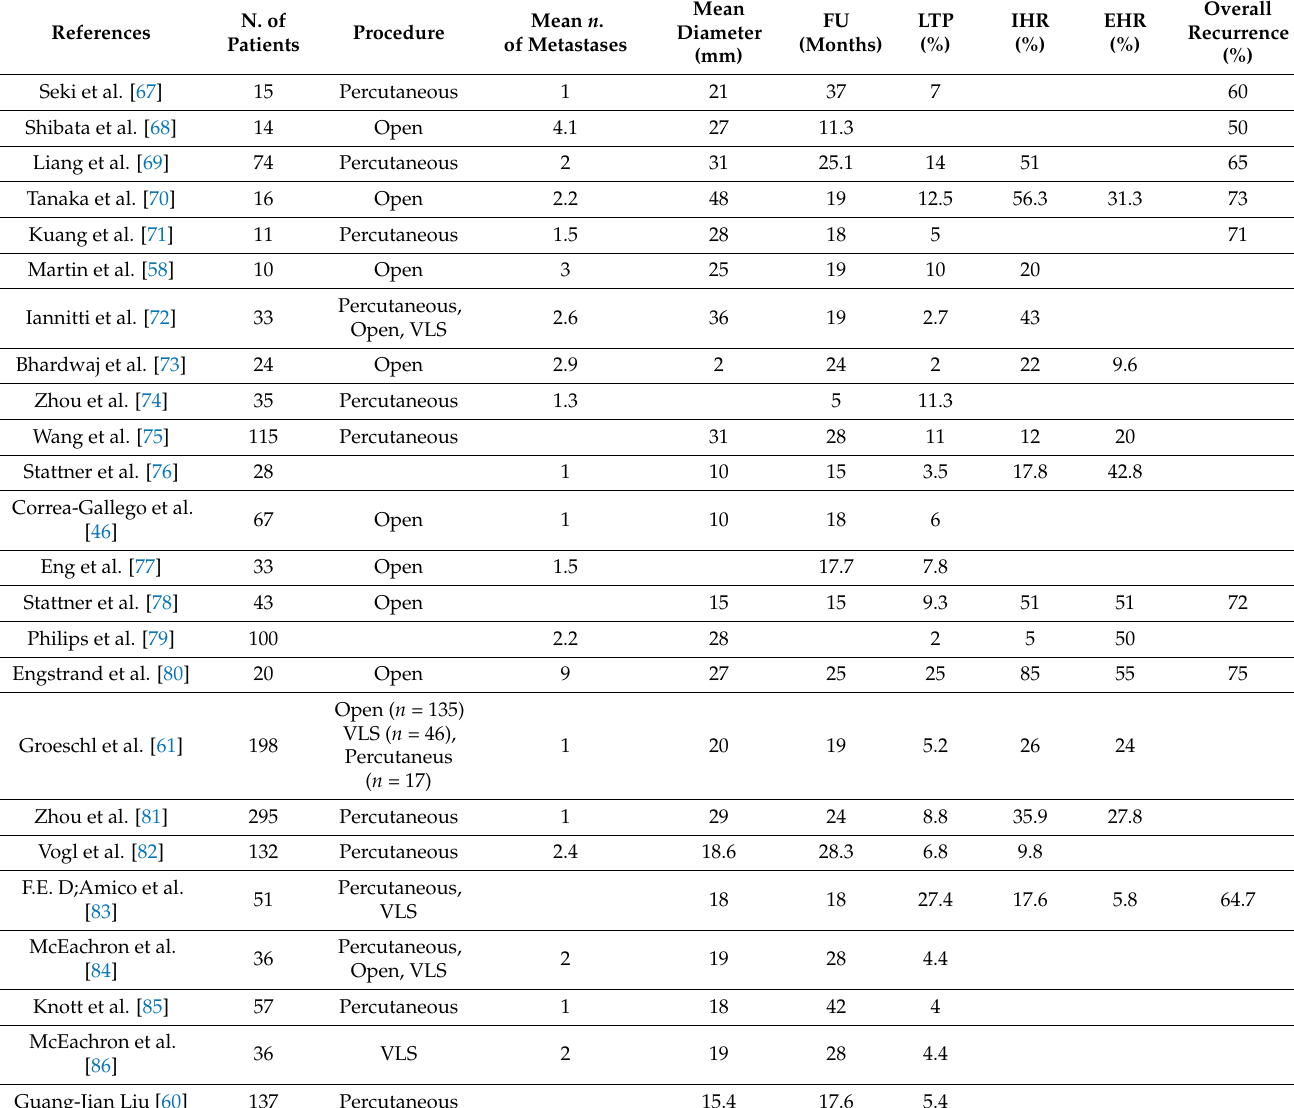
Table 3. Rates of recurrence after MWA for CRLM: a review of the